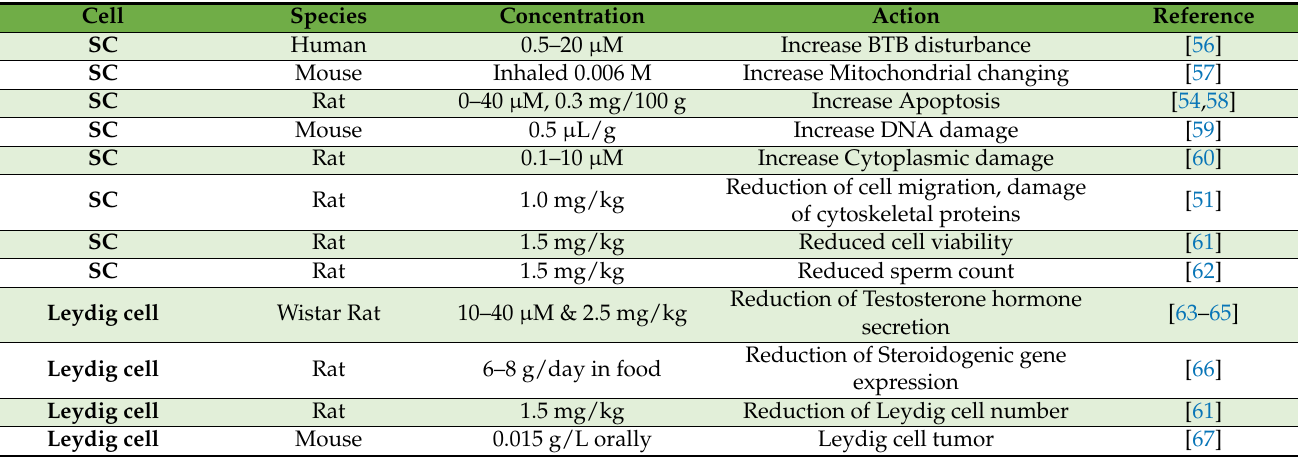
Table 1. Effect of cadmium on SC and Leydig cell of the